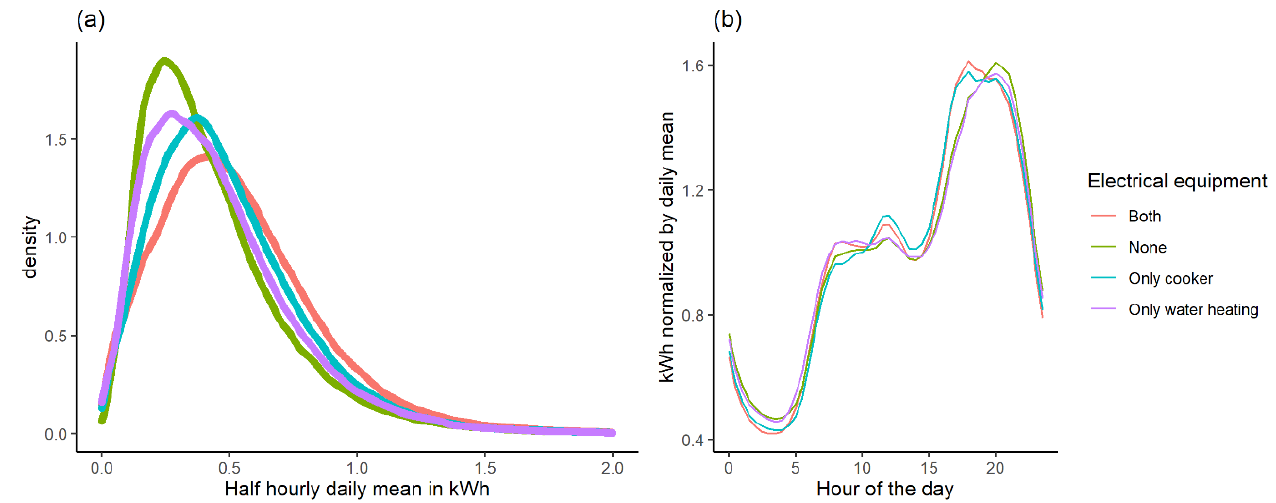
Figure 5. Impact of electrical equipment as declared in pre-trial survey on energy use and shape. ( a ) Half-hourly daily mean density plot. ( b ) Half-hourly daily normalized energy use shape pattern.